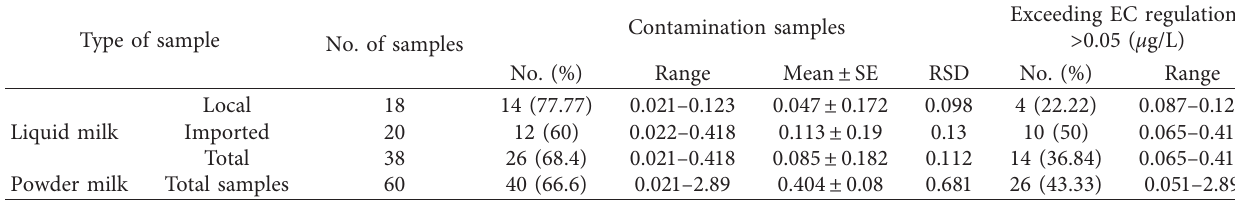
Table 3: AFM1 in liquid and powder milk samples through HPLC.